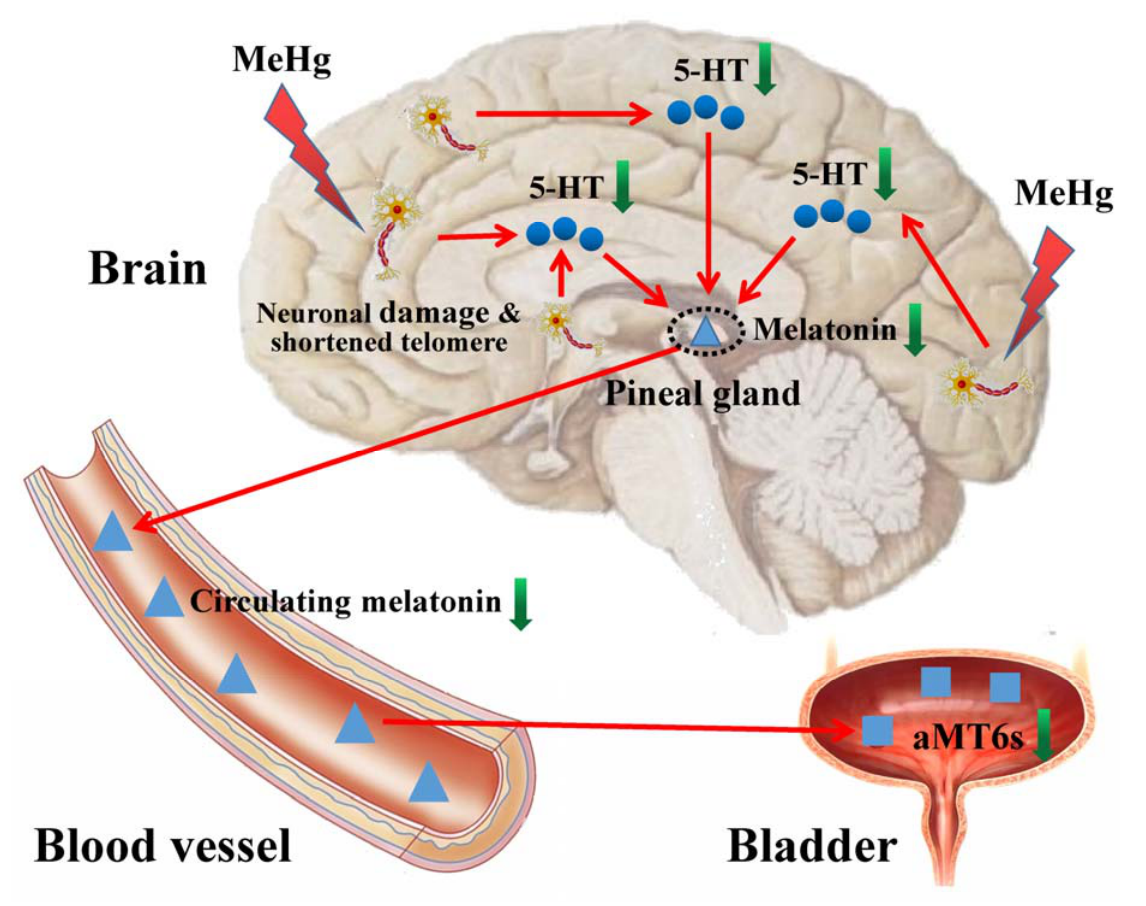
Figure 7. Proposed model of adverse impacts of MeHg on cerebral telomere length and causal relationship with reduced melatonin synthesis and metabolites. The blue dots indicate 5-HT, the blue triangles indicate melatonin and the blue squares indicate aMT6s.